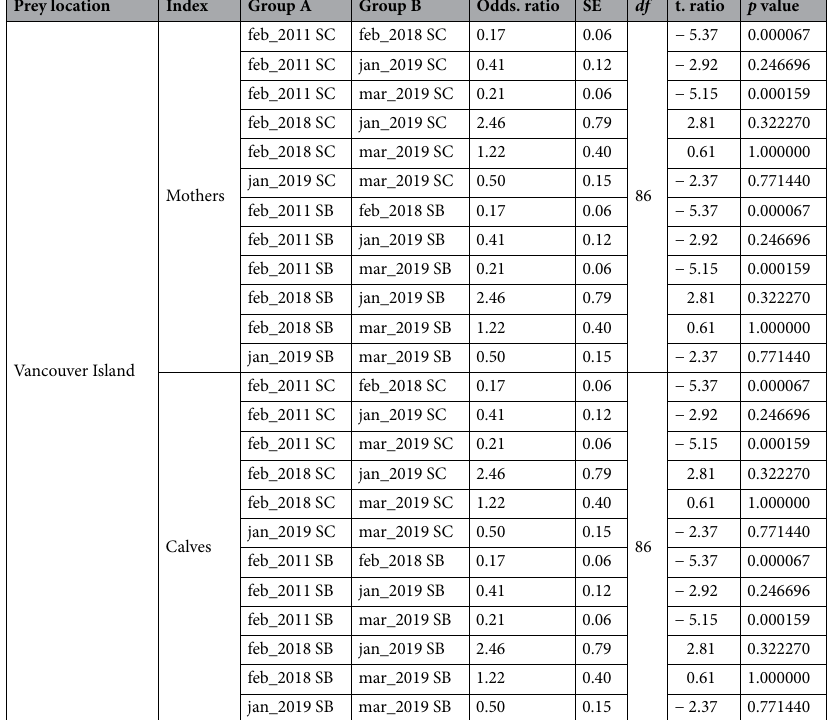
Table 2. Post-hoc analysis results for general linear mixed effect model predictions for Vancouver Island mysids contribution based on “layer” (SC, SB) within each “age” (mothers; calves) and between “year and month” of